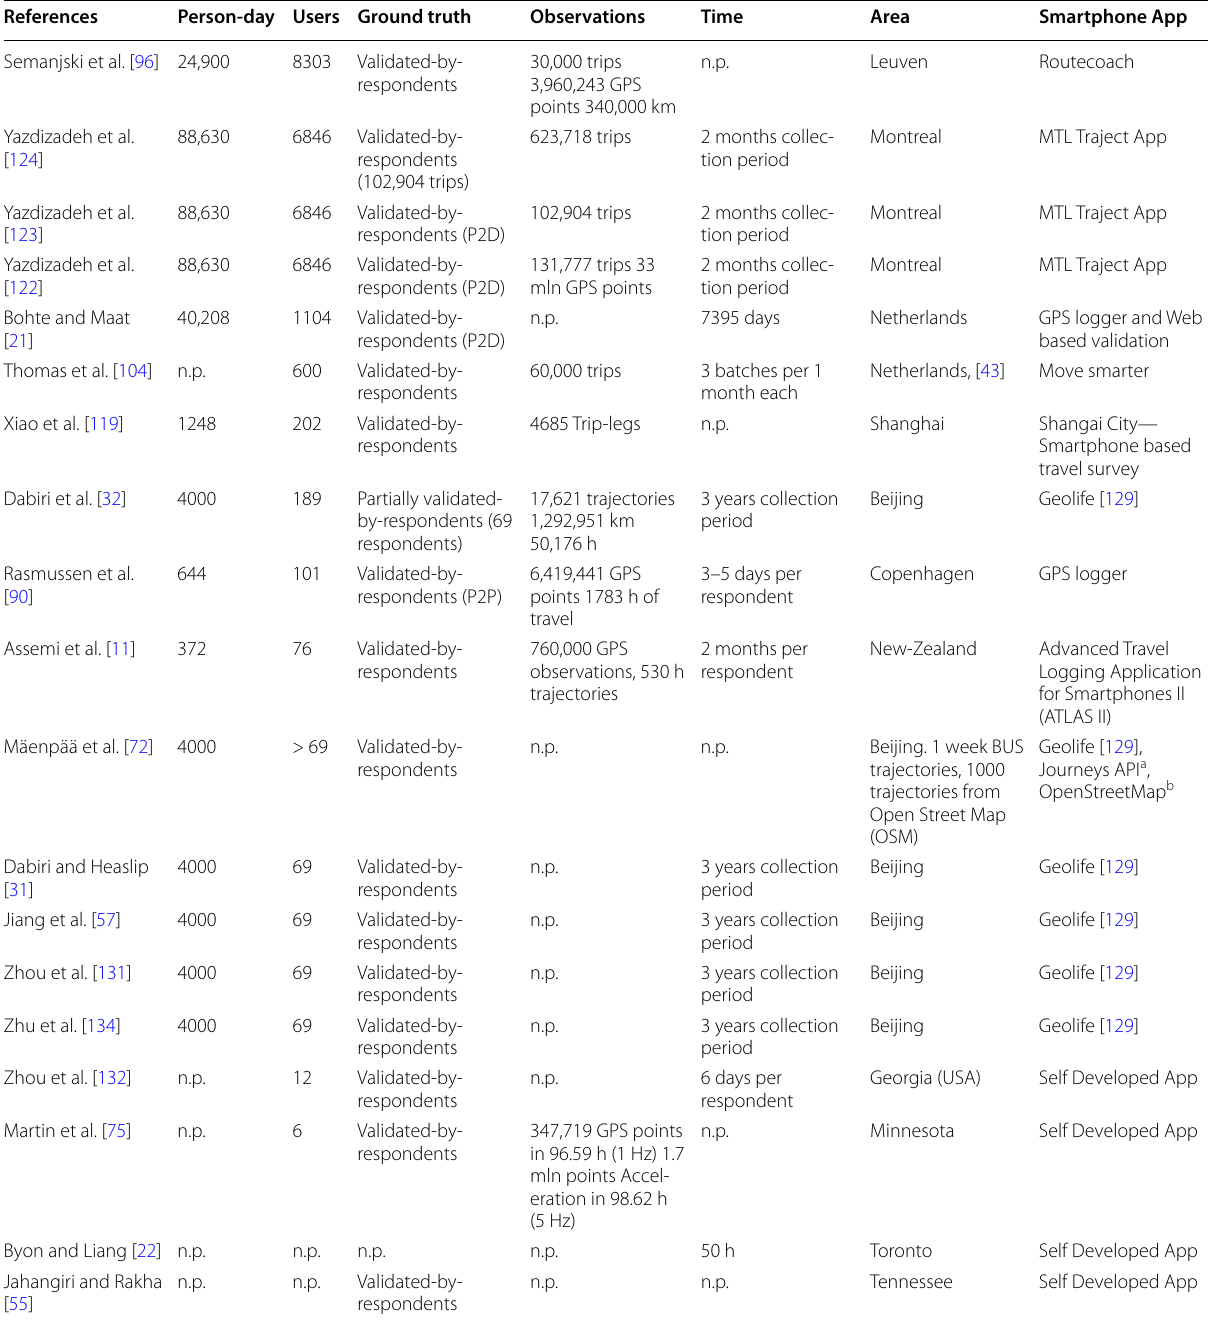
Table 2 Dataset ranked by number of users, for mode